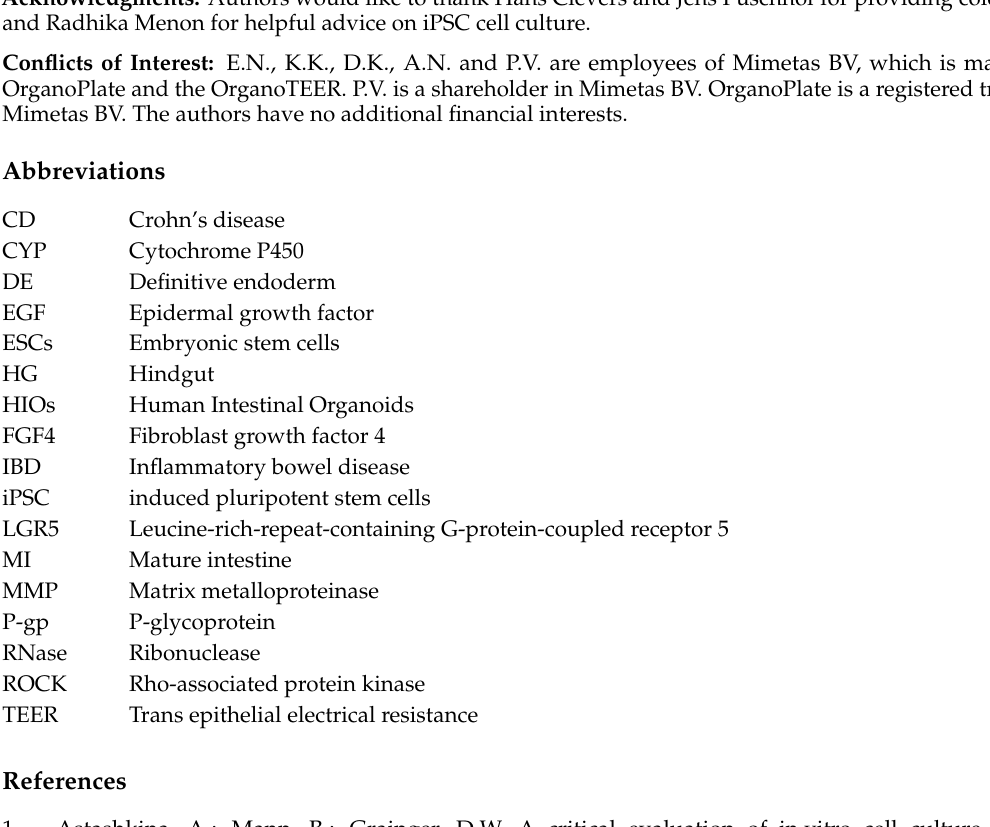
Figure S1: Optimization of ECM and coating strategy for better attachment and tubule maintenance of iPSC; Figure S2: Endodermal potential screen and barrier integrity of iPSC; Figure S3: Maintenance of tubular shape of di ff erentiated iPSC derived gut-like tubules within a microfluidic device with matrix metalloproteinases inhibitors; Table S1: Components of directed di ff erentiation